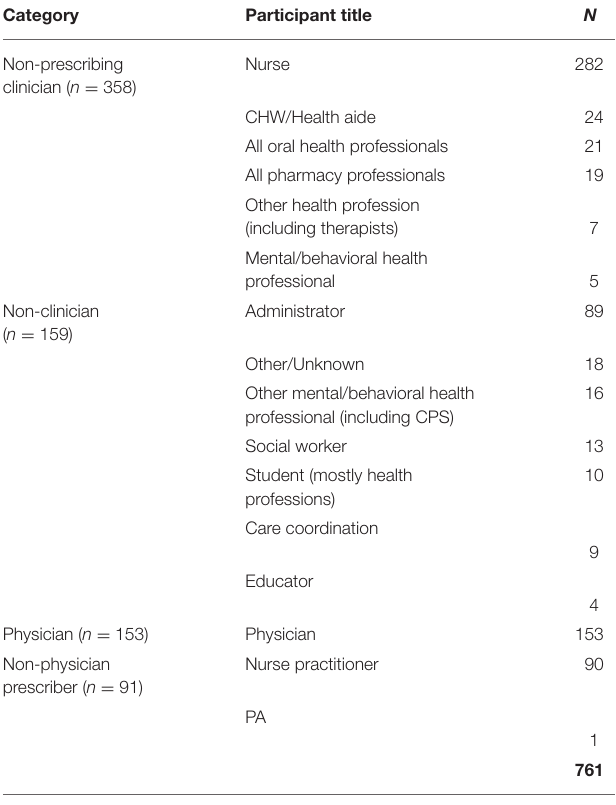
TABLE 1 | COVID-19 ECHO participant